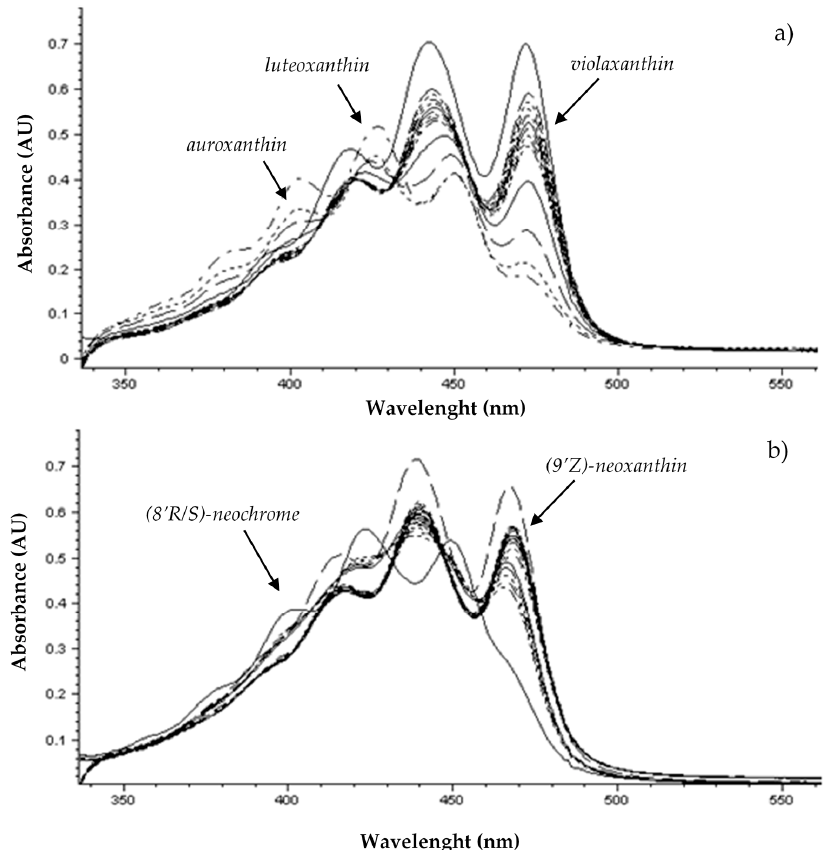
Figure 3. UV-Vis spectra of ( a ) violaxanthin and ( b ) (9 ′ Z)-neoxanthin (3 μ g/mL) treated with tartaric acid (15 g/L).